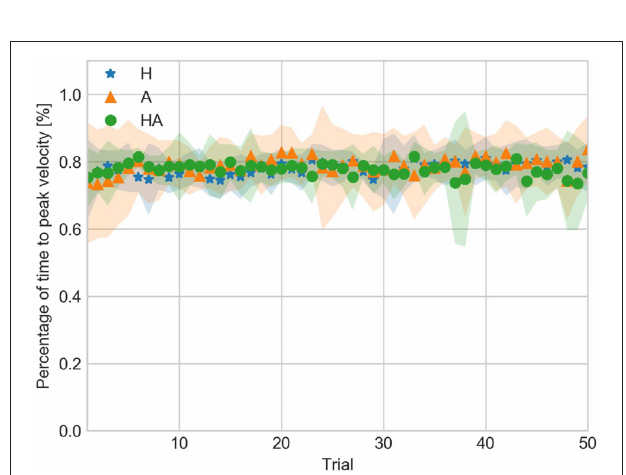
FIGURE 6 | Deviation from contact to target velocity against trial number averaged over all subjects for the haptic (H), acoustic (A), and haptic-acoustic (HA) conditions. The contour represents the standard deviation.